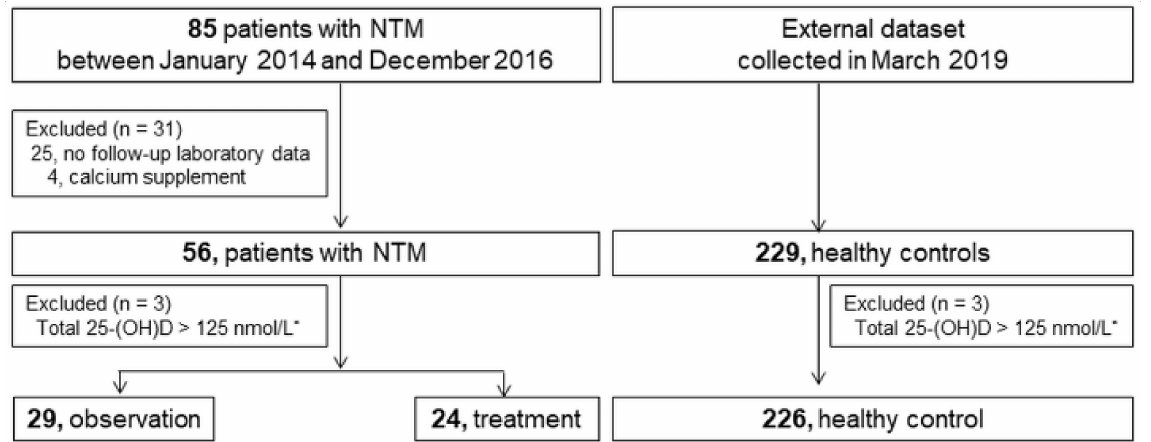
Figure 1. Flow-chart of included and excluded patients with nontuberculous mycobacterial pulmonary disease (NTM) and healthy controls. NTM, nontuberculous mycobacterium; * To minimize the possibility of taking dietary supplements, patients with a total 25-(OH)D ≥ 125 nmol/L were